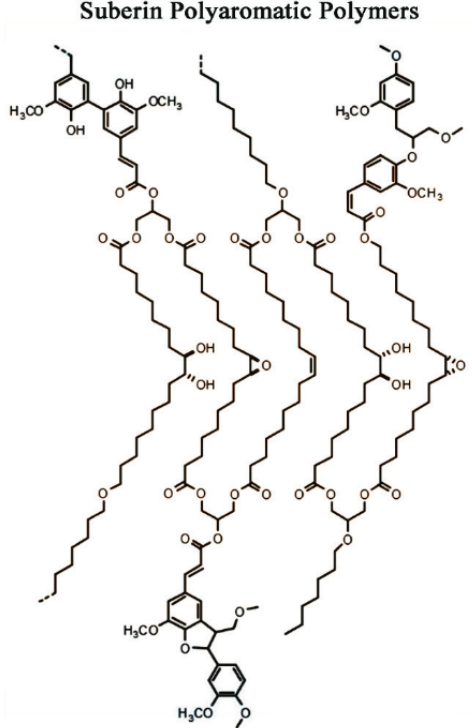
Figure 4. Macromolecular structure of suberin polyester.